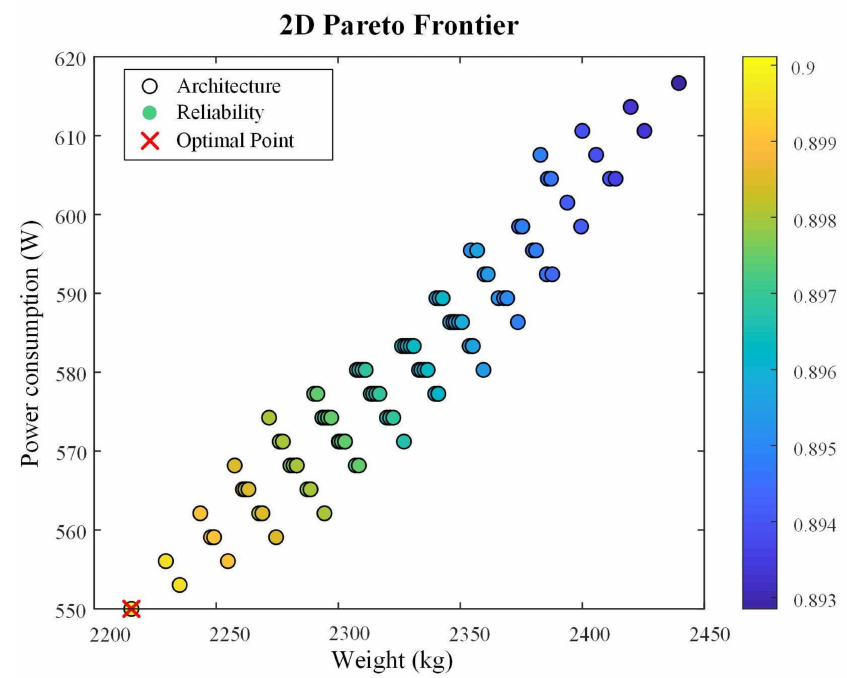
Figure 12. 2D Pareto frontier between weight, power consumption, and